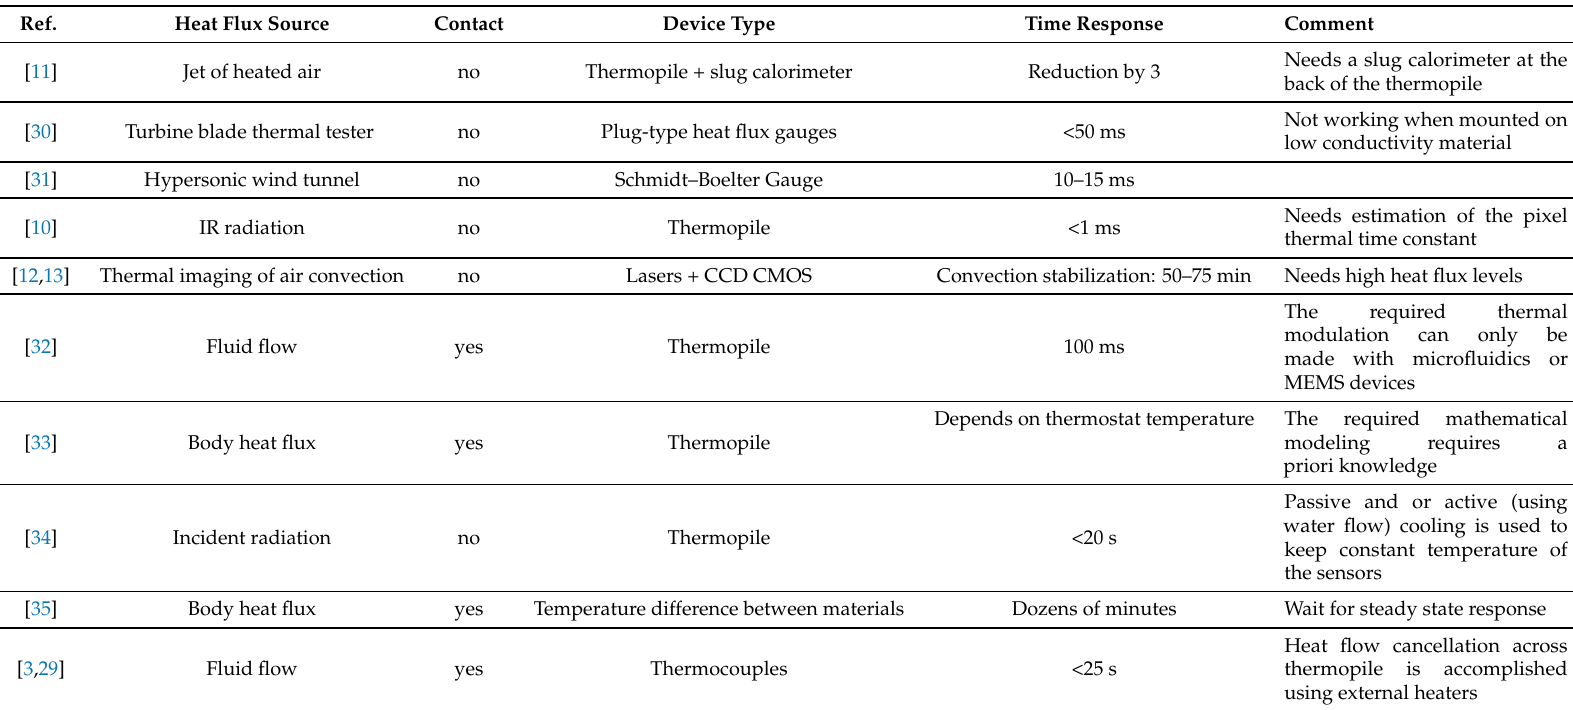
Table 1. Different strategies for heat flux